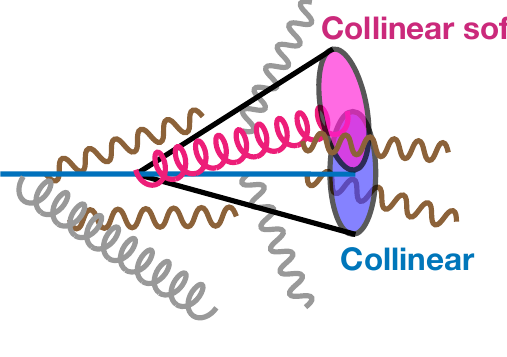
Figure 6 . The catchment area (blue and pink shaded regions) of nonperturbative particles (wavy lines) set by the perturbative collinear and collinear-soft subjets with angular ordering of pertur- bative subjets. The particles shown in gray are groomed away. NP particles are not assumed to obey angular